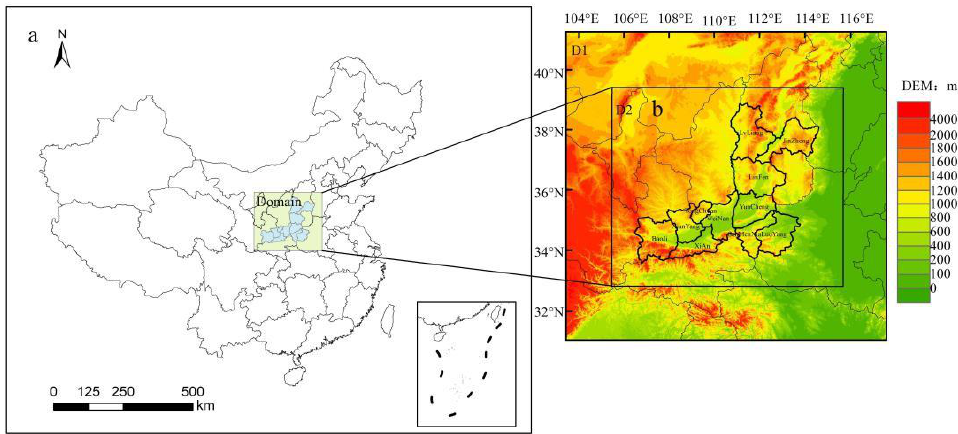
Figure 1. Overview of the study area: ( a ) location of the study area within the provinces and other administrative boundaries of China and ( b ) digital elevation map of the study area.